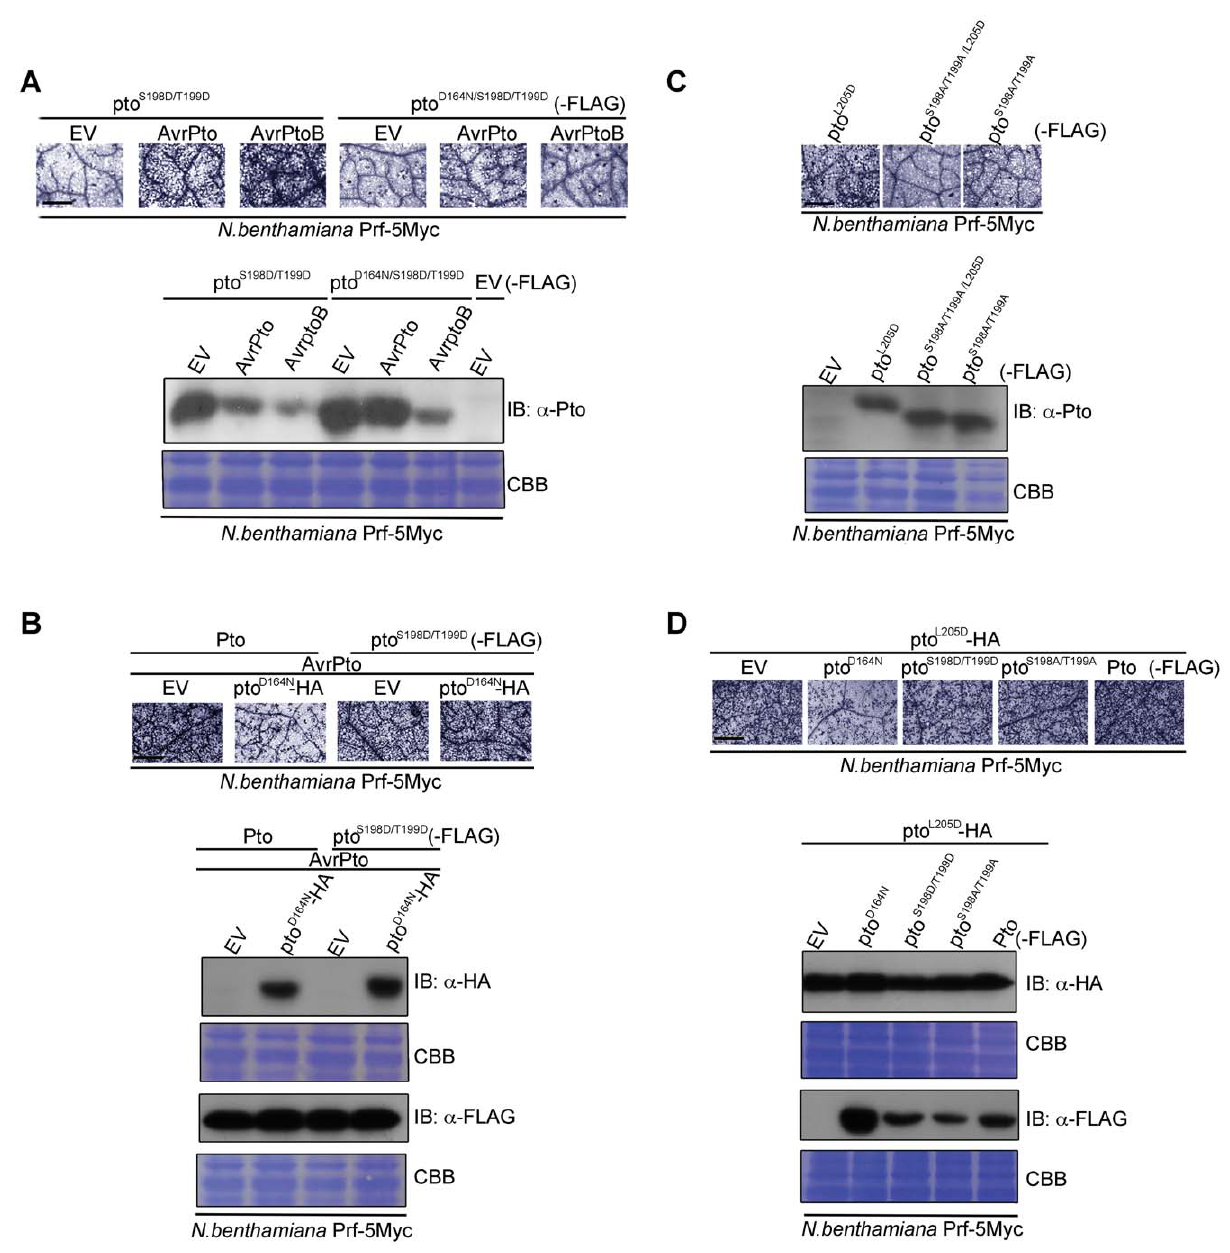
Figure 4. Transphosphorylation is required for signalling. ( A ) The phospho-mimic mutant pto S198D/T199D induced cell death after AvrPto and AvrPtoB recognition. pto S198D/T199D -FLAG, pto D164N/S198D/T199D -FLAG, AvrPto, and AvrPtoB constructs were transiently expressed in Pro Prf : Prf-5Myc N. benthamiana as indicated. Cell death was visualized with trypan blue staining two days post infiltration. Relative accumulation of pto S198D/T199D and pto D164N/S198D/T199D was detected with immunoblot (IB) with a nti -Pto antibody. Coomassie Brilliant Blue (CBB) staining of the IB membrane verified equal protein loading. ( B ) AvrPto-induced signalling by the phospho-mimic mutant pto S198D/T199D is not suppressed in trans by pto D164N . Pto-FLAG, pto S198D/T199D -FLAG, pto D164N -HA and AvrPto constructs were transiently expressed in Pro Prf : Prf-5Myc N. benthamiana as indicated. Cell death was visualized as in A and relative accumulation of proteins was detected with IB with the indicated antibodies. CBB staining of the IB membranes verified equal protein loading. ( C ) Phosphorylation of the kinase-inactive, constitutive gain-of-function (CGF) mutant pto L205D at Ser-198 and Thr-199 is required for its hypersensitive cell death response inducing ability. pto L205D -FLAG, pto S198A/T199A/L205D -FLAG and pto S198A/T199A -FLAG constructs were transiently expressed in Pro Prf : Prf-5Myc N. benthamiana as indicated. Cell death was visualized as in A and relative accumulation of proteins was detected with IB with anti-Pto antibody. CBB staining of the IB membranes verified equal protein loading. ( D ) Signalling by the kinase-inactive, CGF mutant pto L205D mutant is suppressed in trans by pto D164N . pto L205D -HA, pto D164N -FLAG, pto S198D/T199D -FLAG, pto S198A/T199A -FLAG and Pto-FLAG constructs were transiently expressed in Pro Prf : Prf-5Myc N. benthamiana as indicated. Cell death was visualized as in A and relative accumulation of proteins was detected with IB with the indicated antibodies. CBB staining of the IB membranes verified equal protein loading. For all images, the bar indicates 0.5 mm. Each row of trypan blue staining is derived from a single leaf, within which relative amounts of cell death were comparable, and representative of six replicates.